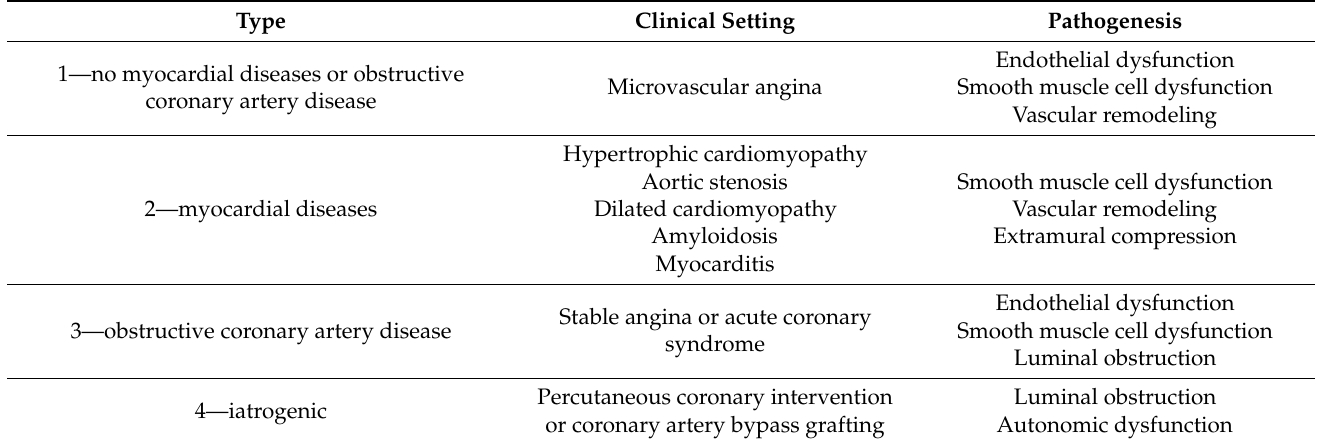
Table 1. Classification of CMD